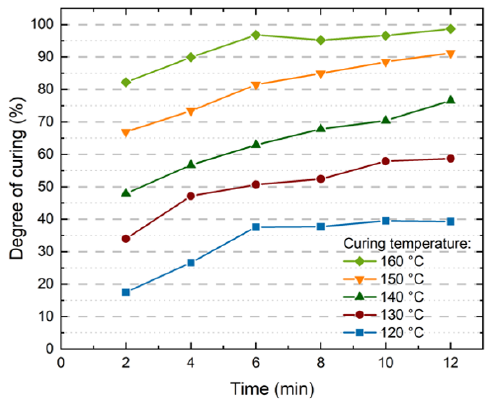
Figure 10. Correlation between the Degree of curing as measured by DSC of the processed 30 samples and the lamination parameters time and